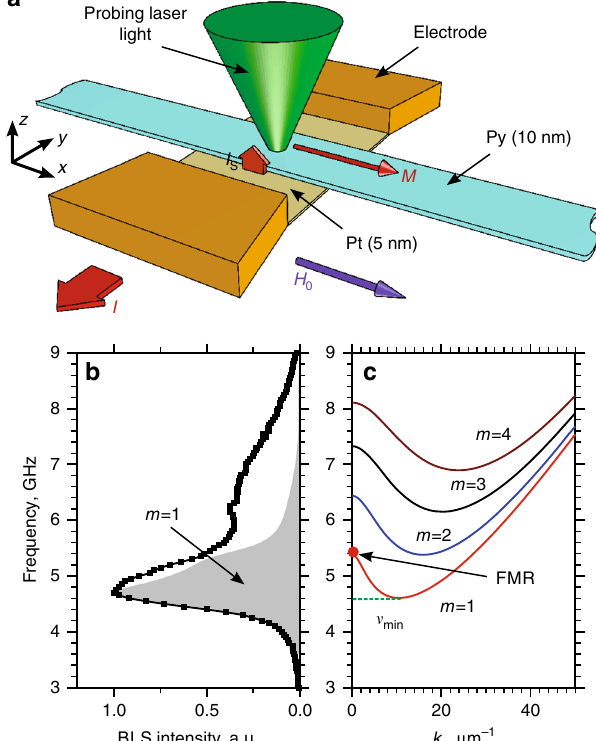
Fig. 1 Studied system. a Schematic of the experiment. b BLS spectrum of magnons in the Py strip measured at I = 0 and H 0 = 200 Oe. Shaded area shows the calculated BLS response for the fundamental magnon mode m = 1. c Calculated dispersion spectrum of magnon modes in the Py strip. m is the mode index, ν min is the frequency of the lowest-energy magnon